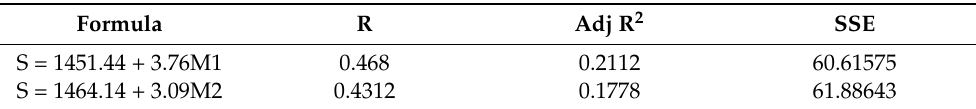
Table 4. Regression formulae for males with its correlation coefficient (R), adjusted determination coefficient (Adj R 2 ), and standard error of estimate (SEE).